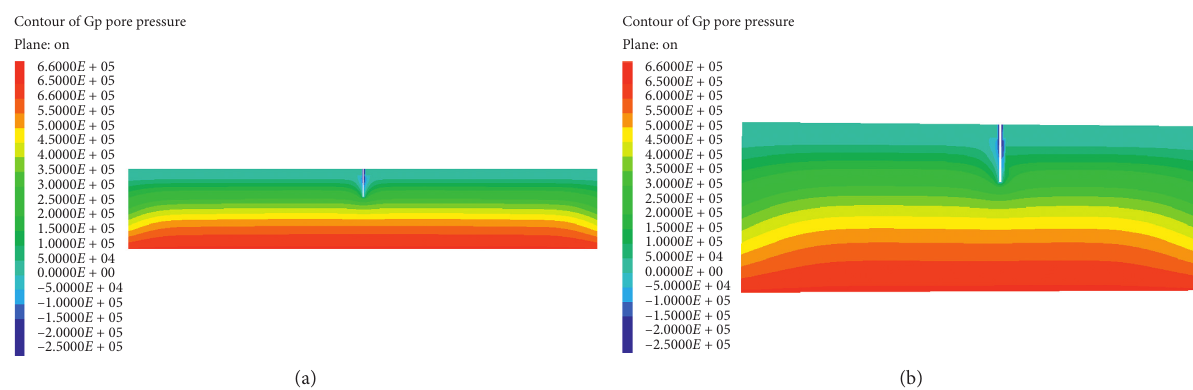
Figure 21: Single well pore water pressure nephogram after the third drawdown (unit: Pa). (a) Cross section of the well midpoint. (b) Longitudinal section of the well